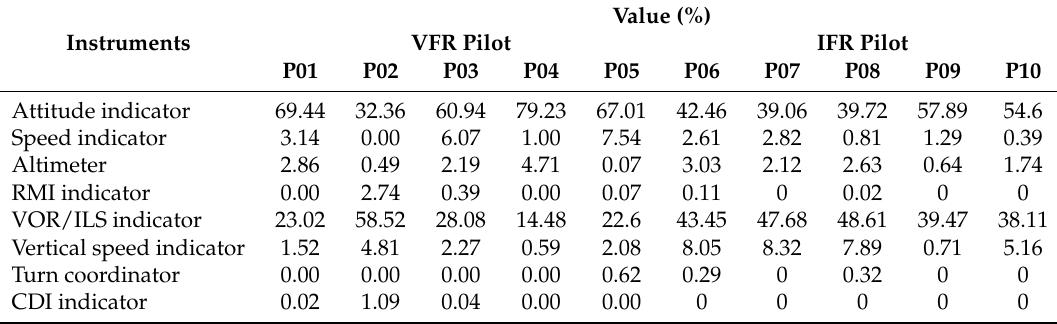
Table 7. Percentage contribution of individual instruments in the process of vision: VFR and IFR pilots.